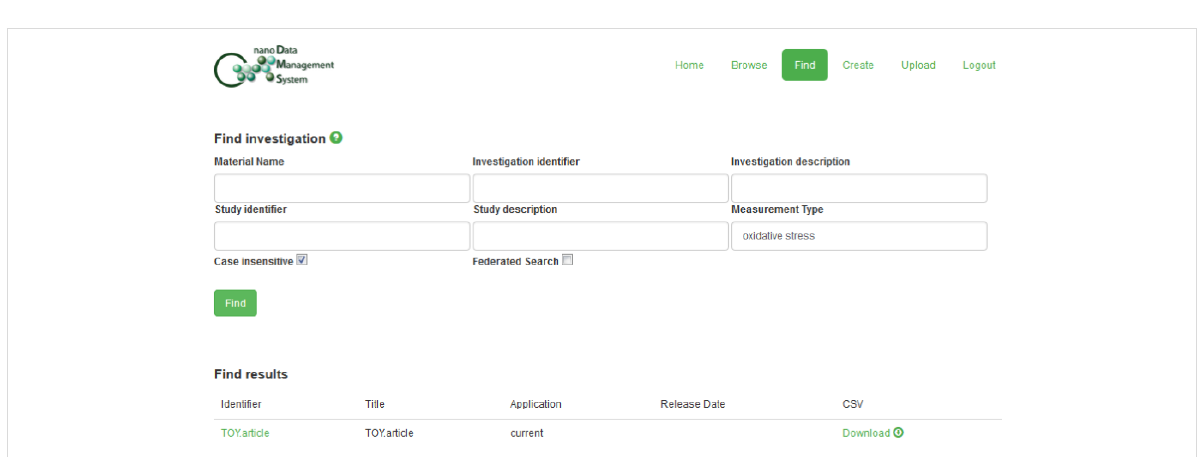
Figure 7: Retrieving the “Toy Dataset” (Supporting Information File 3) via searching for "oxidative stress" data in the nanoDMS